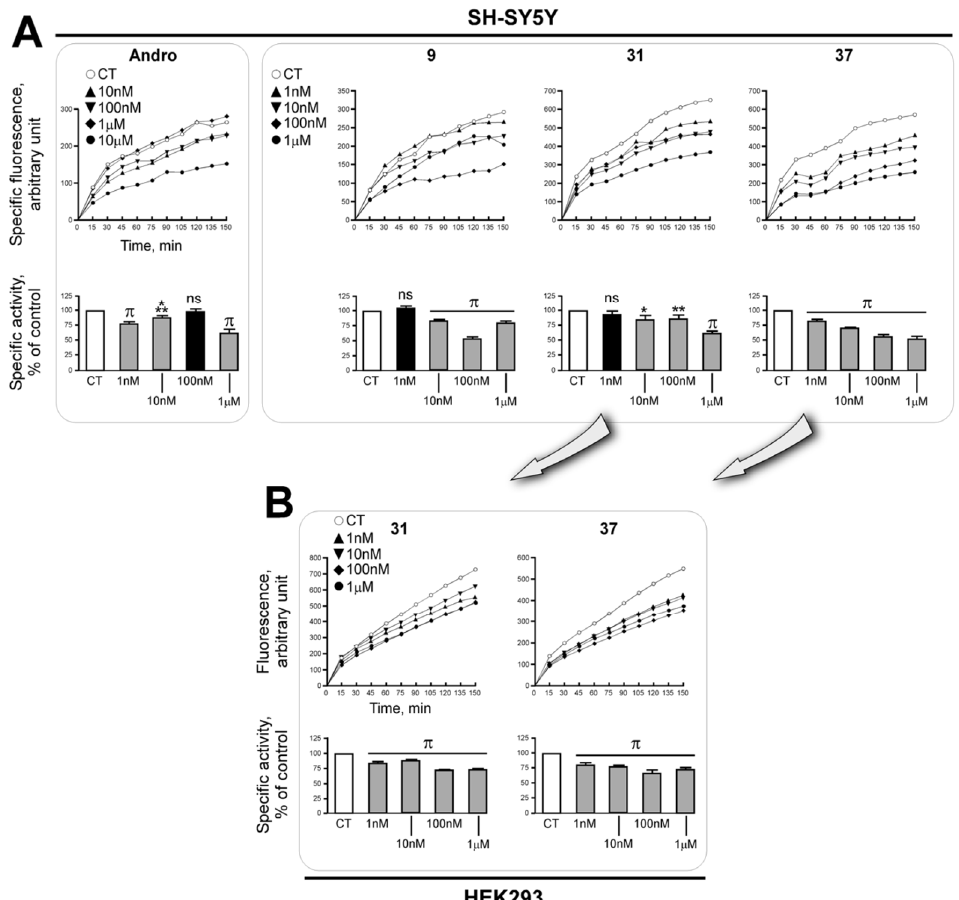
Figure 7. Effects of andrographolide and compounds 9 , 31 , and 37 on the β -secretase catalytic activity in human cells. ( A ) The β -secretase catalytic activity (JMV1197-sensitive hydrolysis of the fluorimetric substrate JMV2236) was measured in SH-SY5Y cell extracts in the absence (control, white circle/white bar) or in the presence of various concentrations of the compounds (1 nM to 1 μ M for andrographolide; 1 nM to 1 mM for compounds 9 , 31 , and 37 ). ( B ) Experiments carried out with 31 and 37 under the same conditions in HEK293 cell extracts. The curves represent the mean specific fluorescence (from 2 to 3 independent experiments including two controls each) while bars in histograms are expressed as a percentage of control (white bars, non-treated cells) calculated from the linear parts of the curves (initial velocity) and are the means ± SE of 6 to 15 independent determinations. * p < 0.05; ** p < 0.03; *** p < 0.02; π p < 0.0001 (gray bars); ns, no statistical difference (black